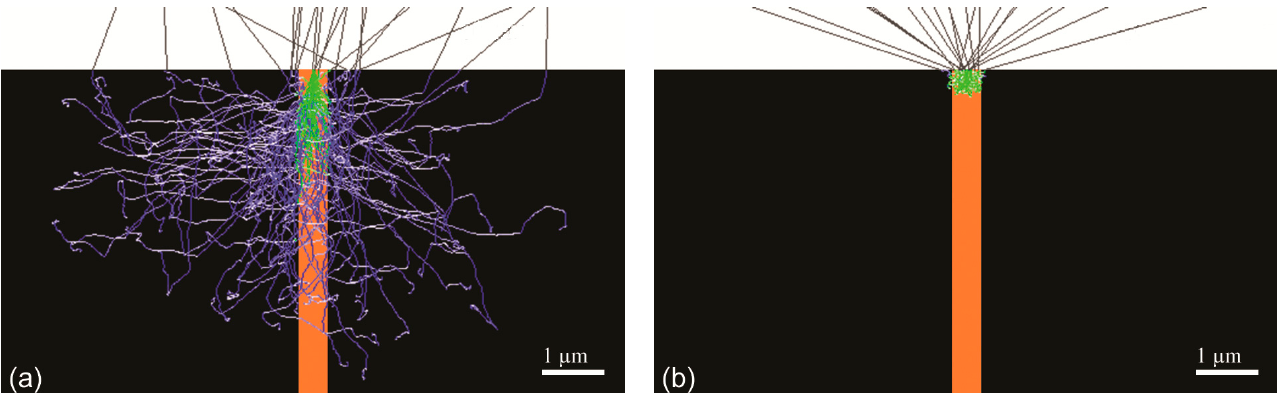
Figure 2. Bidimensional projections of the three-dimensional electron trajectories simulated inside a basalt-derived glass fibre (orange area, radius of 300 nm, “infinite” height) embedded in a K-PSS geopolymer matrix (black area) for an electron beam energy of ( a ) 20 keV and ( b ) 6 keV. When the electrons are moving inside the fibre or the matrix, or when they are escaping the sample surface, the trajectories are coloured in green, blue and grey, respectively.